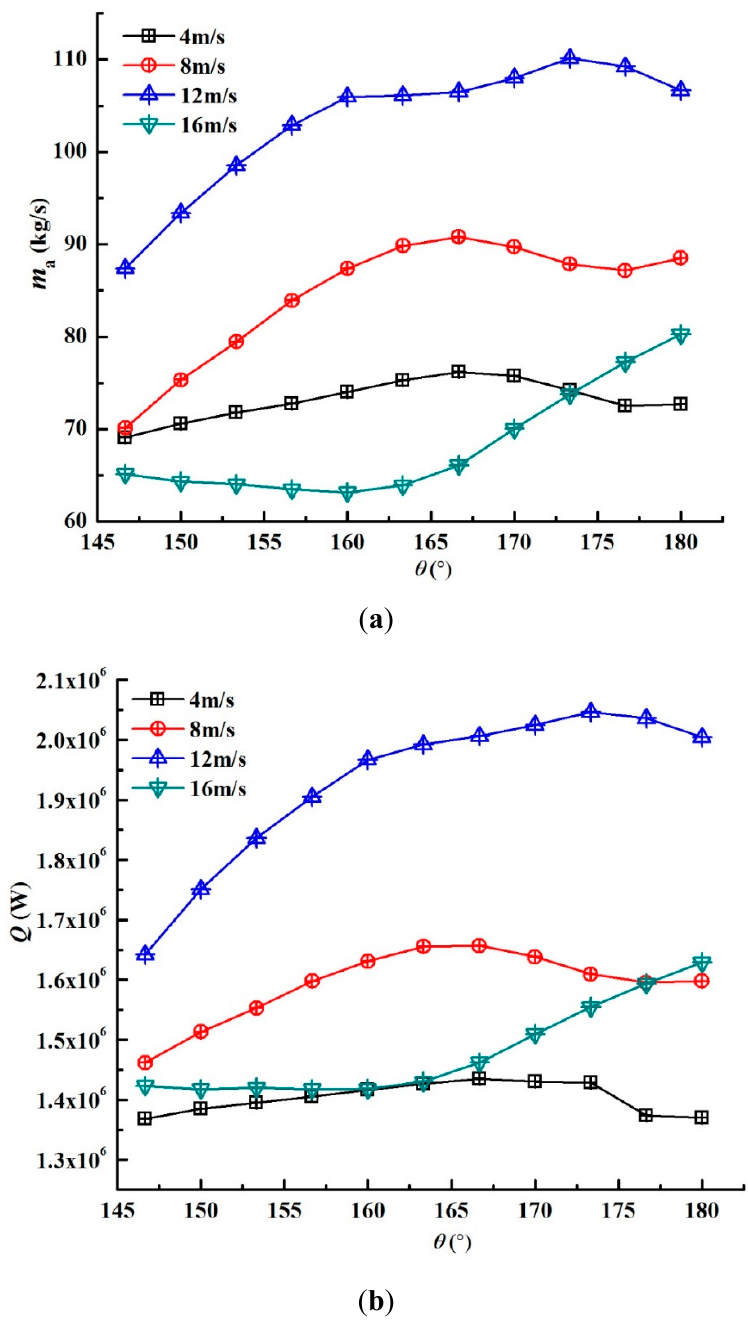
Figure 16. Variable fields of the leeward deltas. ( a ) Pressure and flow fields at 4 m/s, ( b ) pressure and flow fields at 12 m/s, ( c ) pressure and flow fields at 16 m/s, ( d ) outlet air temperature at 4 m/s, ( e ) outlet air temperature at 12 m/s, ( f ) outlet air temperature at 16 m/s.